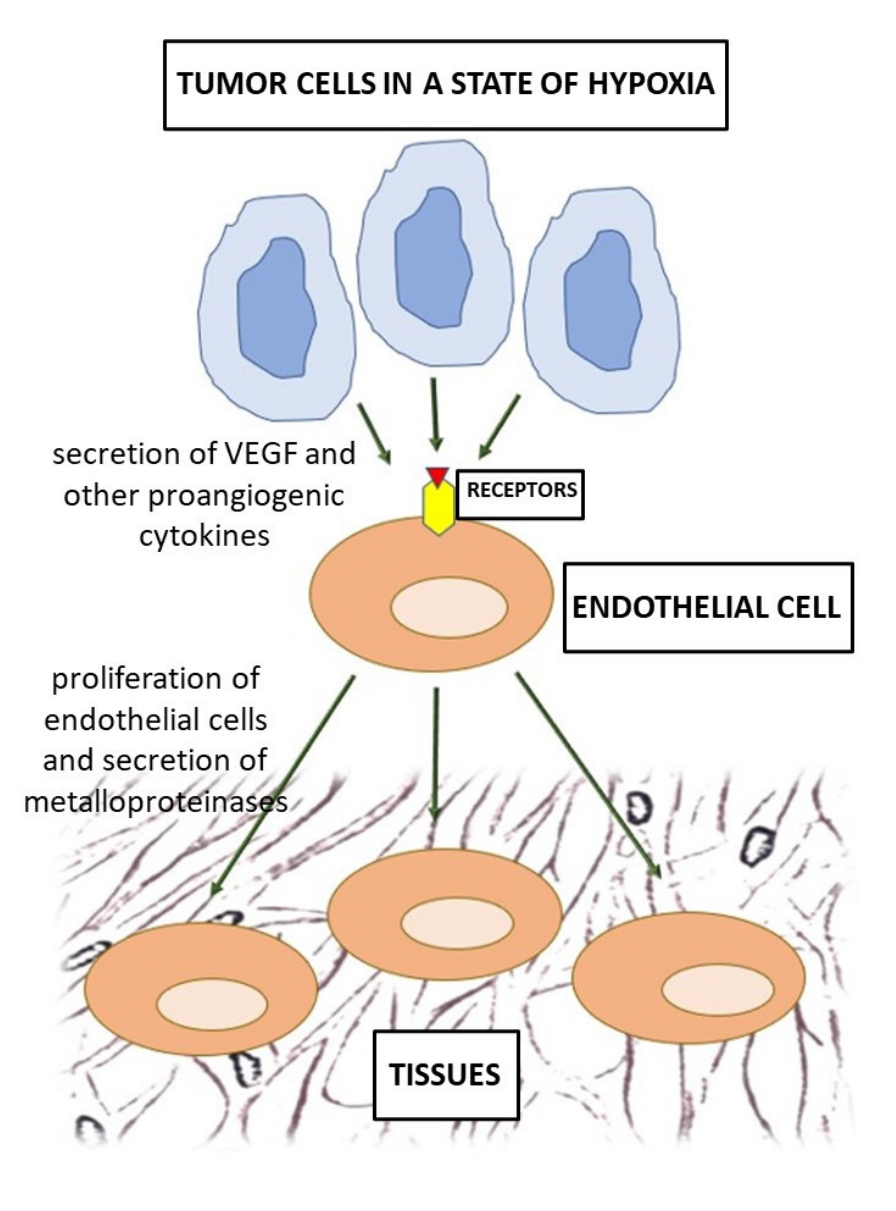
Figure 2. Schematic of the tumor